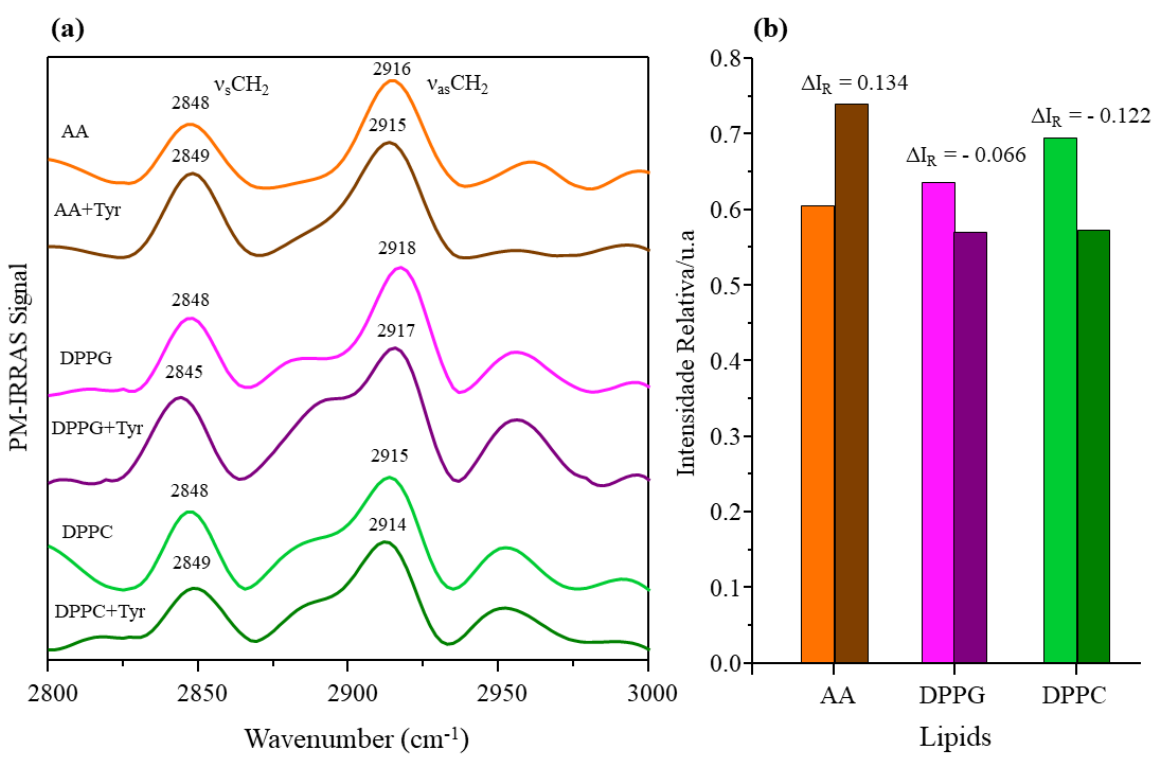
Figure 4. ( a ) PM-IRRAS spectra for AA, DPPG, and DPPC in the absence and presence of Tyr in buffer subphase at room temperature (23 °C) and the surface pressure of 30 mN/m. ( b ) Bar graph of the ratio between the relative intensities of the symmetric and antisymmetric stretching bands from CH